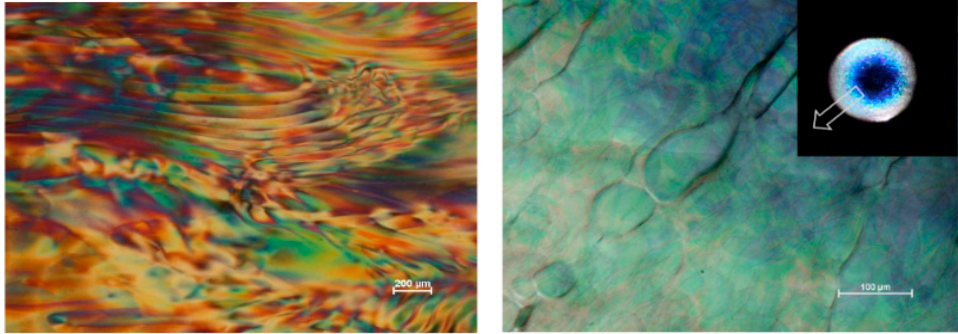
Figure 12. The 6% CNC suspension as viewed from polarized light microscopy [93].